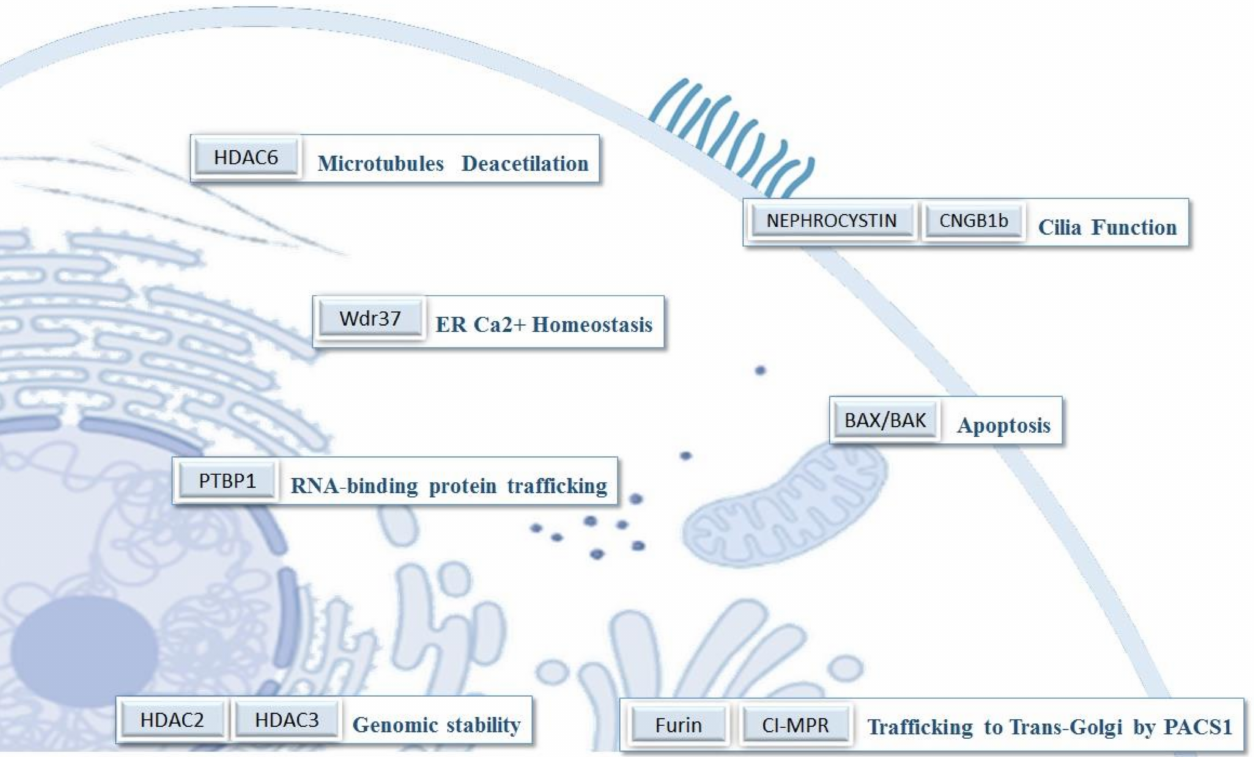
Figure 2. Some of PACS-1’s client proteins and their subcellular location and